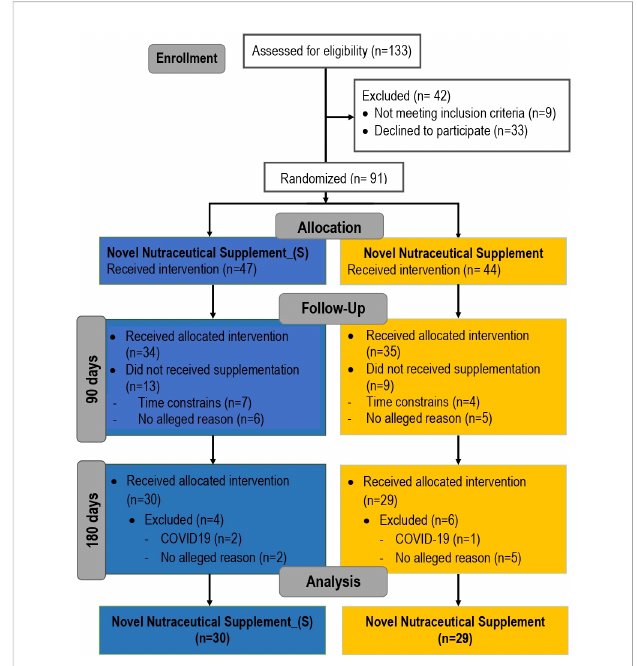
FIGURE 1 Consolidated Standards of Reporting Trials (CONSORT) fl owchart describing the recruitment of volunteers and the experimental design carried out on this clinical trial.